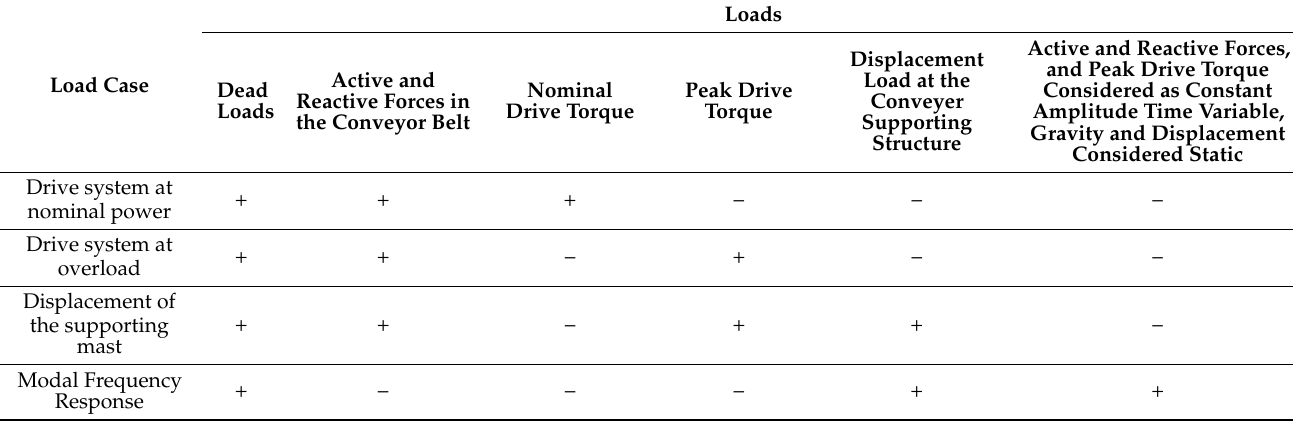
Table 2. External forces included in the FEM analysis—mineral materials processing installation.